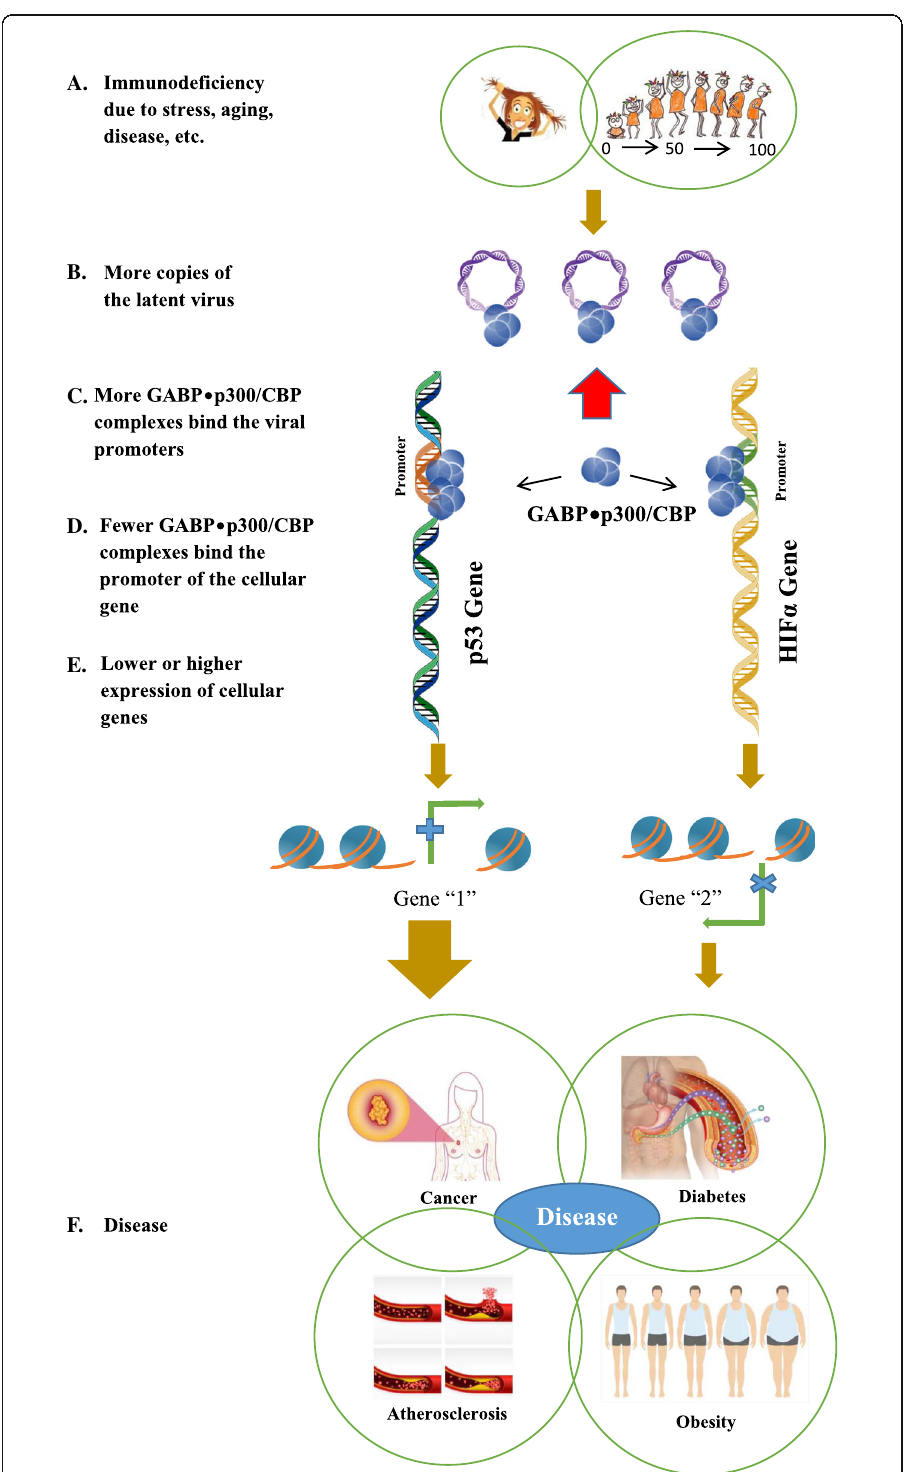
Fig. 1 Latent viruses, the microcompetition model, and disease. a Immunodeficiency occurs due to stress, aging, disease, etc. b More copies of the latent virus are present in the system c Due to the increase in the copies of latent viruses, more GABP (cid:129) p300/CBP complexes bind the viral promoters. d As a result, fewer GABP (cid:129) p300/CBP complexes are available to bind the promoter of the cellular gene. e A lower or higher expression of cellular genes. f Disease